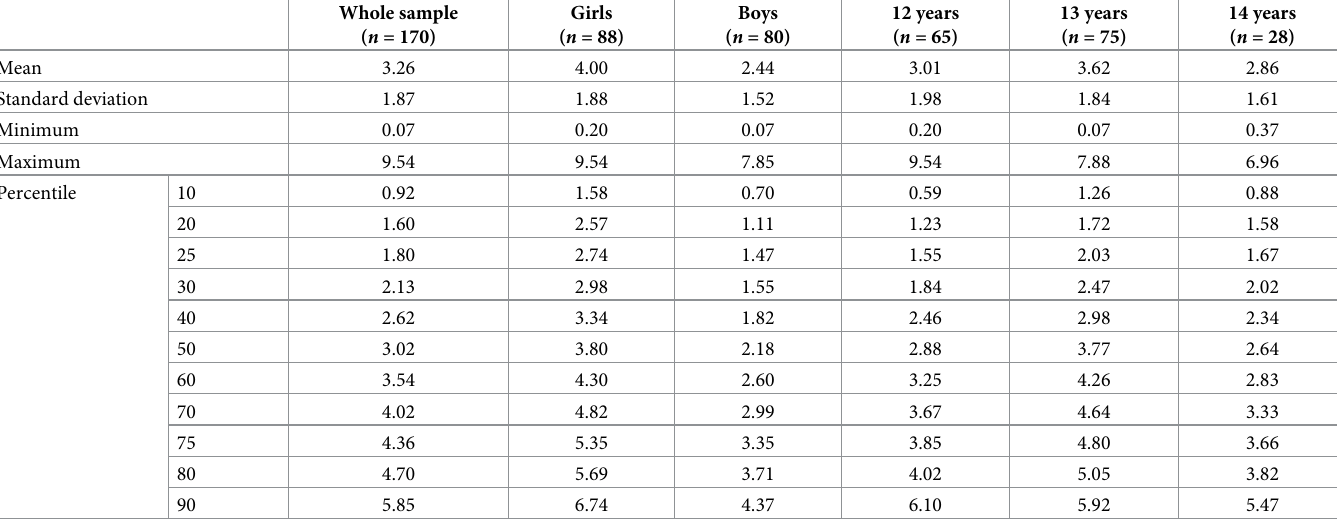
Table 1. Descriptive statistics and HCC reference ranges (pg/mg) for the whole sample and by sex and age.